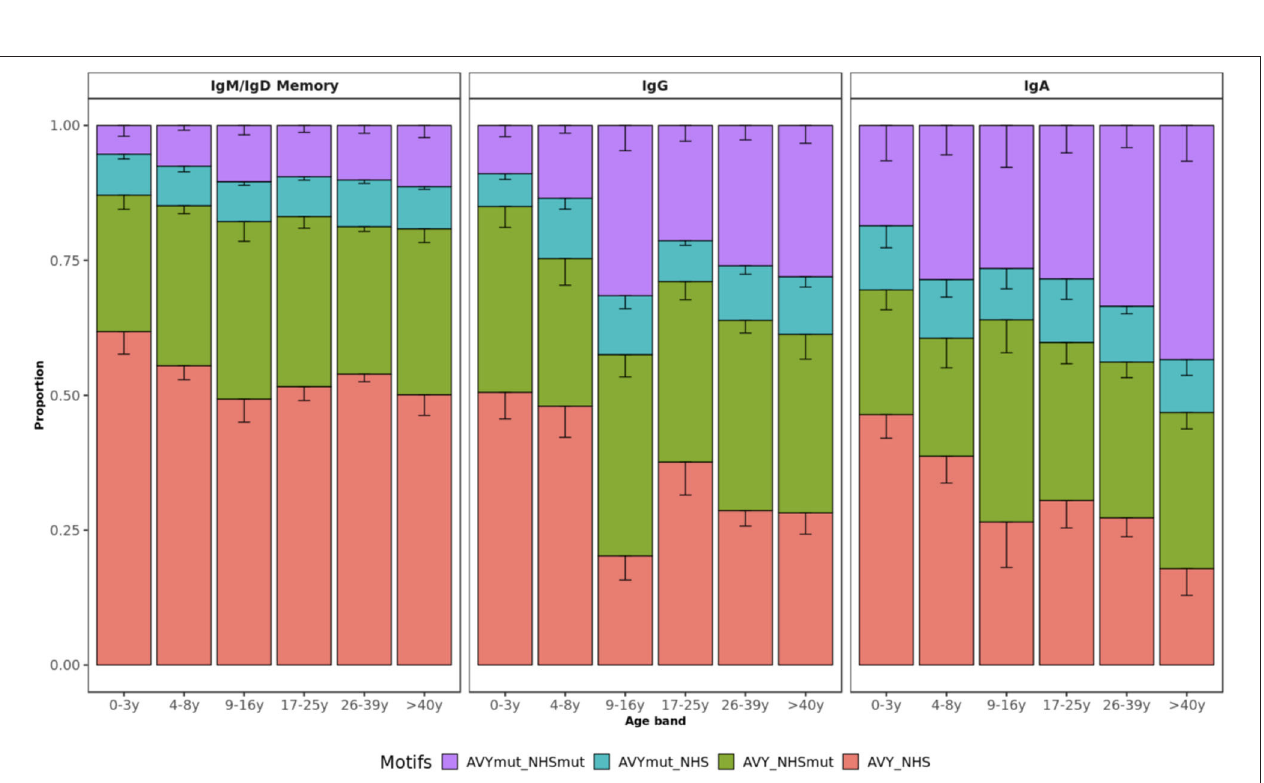
FIGURE 7 | VH4-34 motifs by age group. Bar plots represent the proportion of sequences with mutated AVY and/or NHS motifs in IgD/IgM, IgG, and IgA. Error bars indicate standard error of the mean. Proportion of sequences with both unmutated motifs decreases with age.